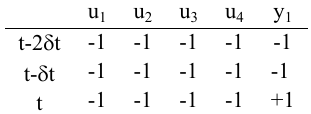
Table 2. Example of a FIR candidate matrix. u